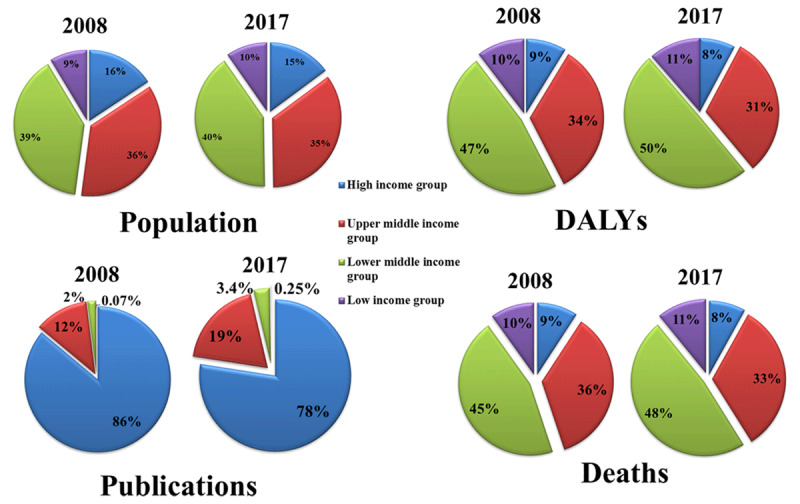
Population, cardiovascular DALY, deaths and publications in World Bank income groups as percentages of global figures.